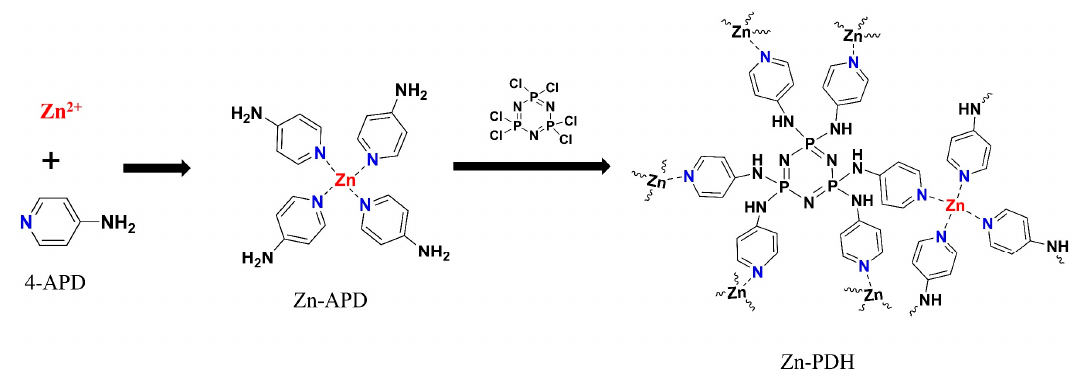
Figure 11. Synthetic route of Zn-PDH.